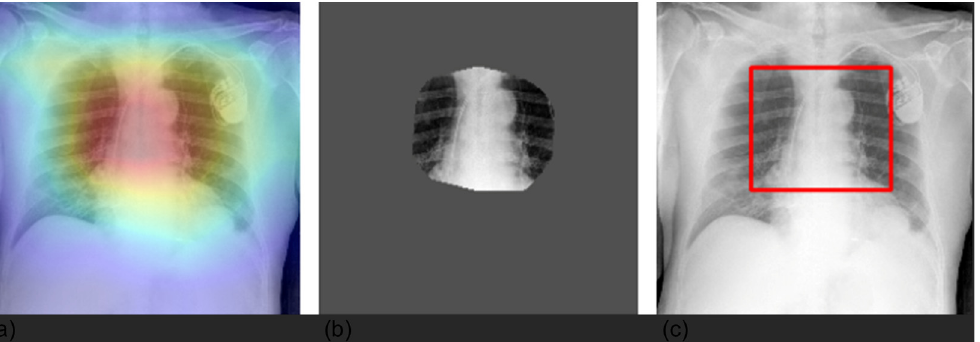
Figure 9. Shortcut for the identification of a pacemaker focusing on the leads: the saliency mask obtained with Grad-CAM (panel a ), the relevant area (mask values higher than the 0.8 quantile) (panel b ), and the respective bounding box (panel c ).